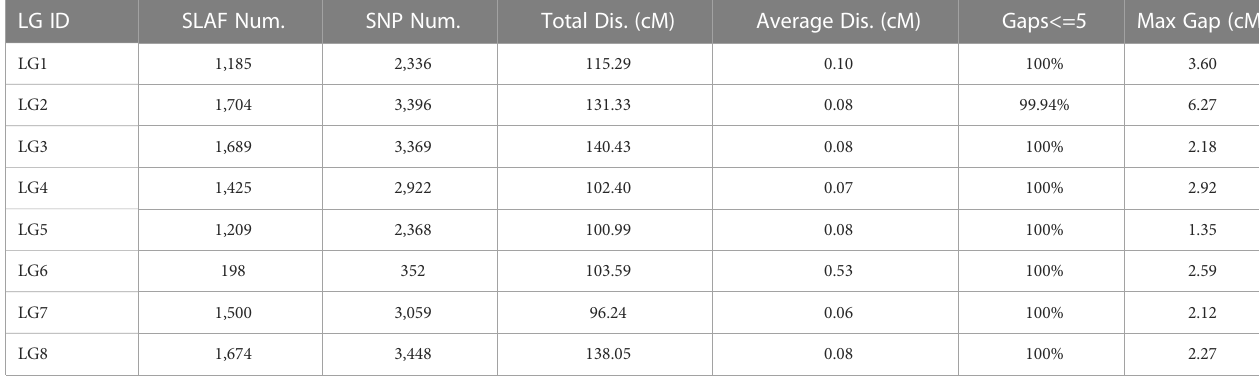
TABLE 2 Basic information for high-resolution genetic map of